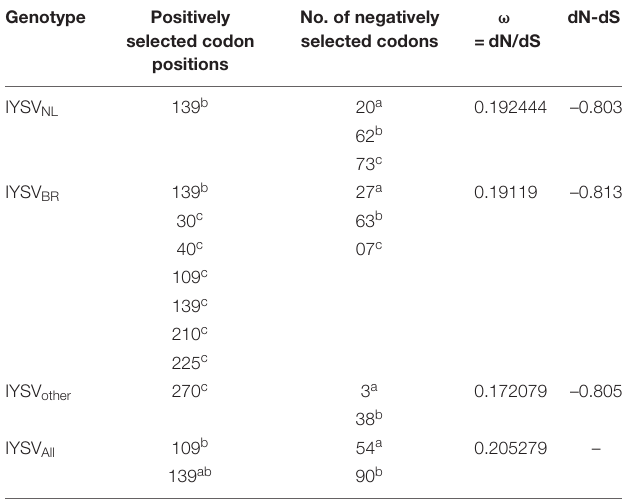
TABLE 1 | Codon substitution in the nucleocapsid gene of Iris yellow spot orthotospovirus genotypes. Genotype